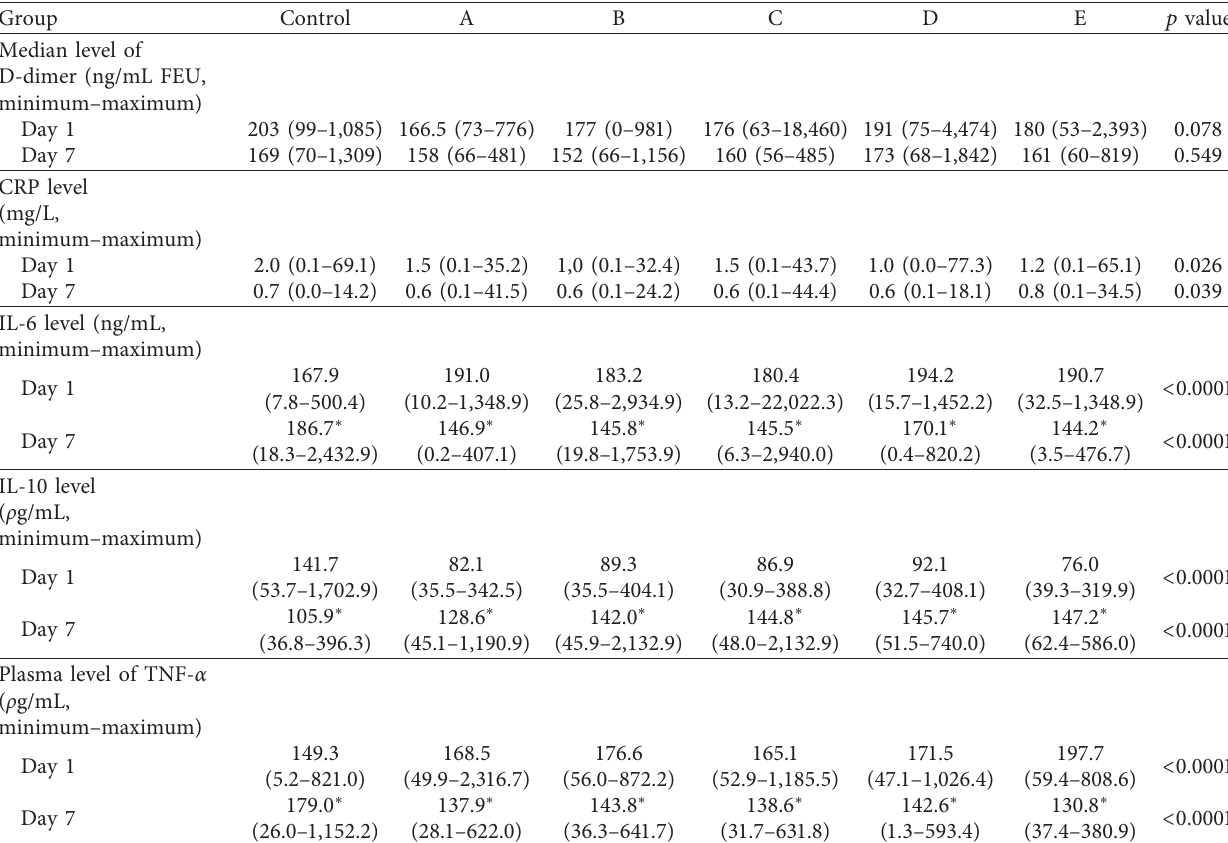
Table 2: Analysis of laboratory data profiles of D-dimer, CRP level, interleukins, and TNF- α of subjects in the Control group and Groups A–E on day 1 and day 7 during